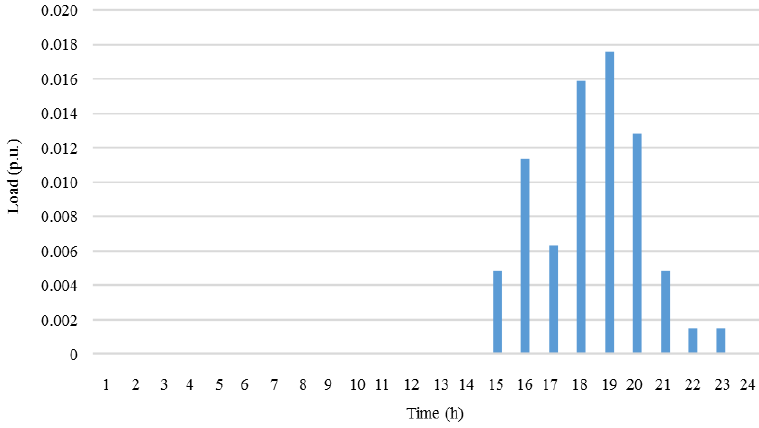
Figure 8. Load demand profile for Case 2 (15 EVs, uncontrolled charging).